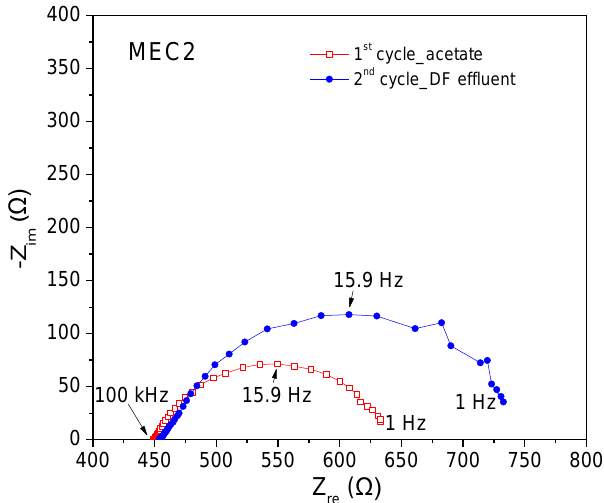
Figure 12. EIS characteristics (Nyquist plots) of MEC2 obtained at 0.9 V applied cell potential and with either acetate synthetic wastewater or DF effluent as feed.